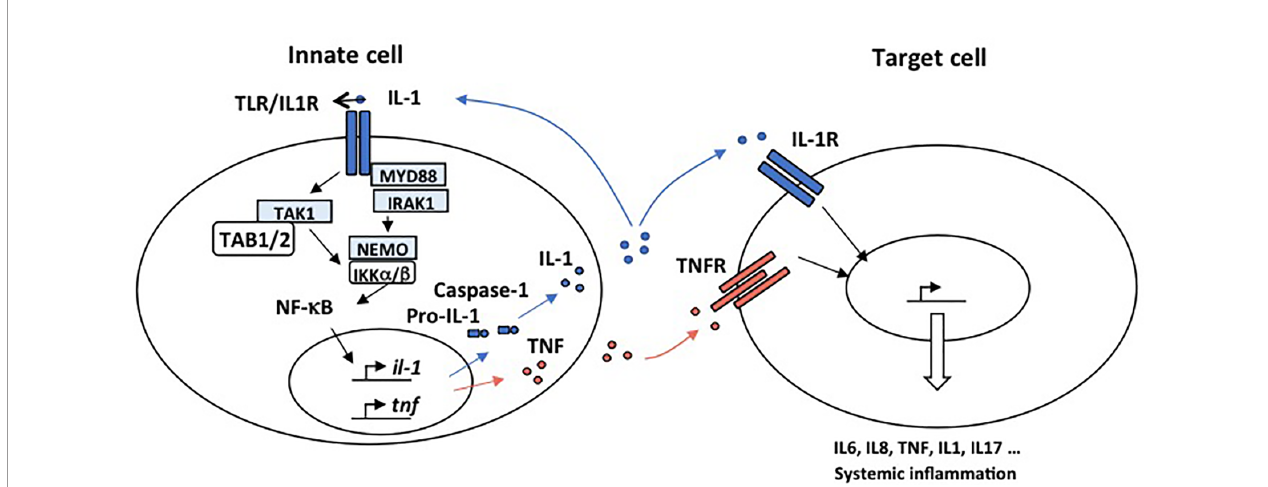
FIGURE 2 | Mechanisms responsible for autoimmunity involving IL-1R and TNFR. IL-1 and TNF a are proin fl ammatory cytokines able to promote systemic in fl ammation. Activation of the IL1R complex is part of the innate immune response and plays a major role in setting up the adaptive response. An “ in fl ammatory cascade ” leading to the cleavage of IL-1 b by Caspase 1 activates this complex. They are important receptors for the initiation of in fl ammation. All IL-1R contain, like TLR, a TIR domain that intact with MyD88 through an homotypic interaction and drive NF- k B activation. IL-1 is well recognized for its role in the pathogenesis of disorders of autoin fl ammation. In autoin fl ammatory diseases, the effector cell is a myeloid cell, characteristically a monocyte or macrophage. IL-1 plays a key role in the expression of several pro-in fl ammatory cytokines. TNF a is a potent proin fl ammatory master cytokine modulating in fl ammatory processes, and its rapid induction is fundamental for the orchestration of the immune response. Monocytes and macrophages are important cellular mediators of TNF-mediated signal transduction. Chronic TNF stimulation leads to in fl ammatory diseases in which NF- k B is activated such as